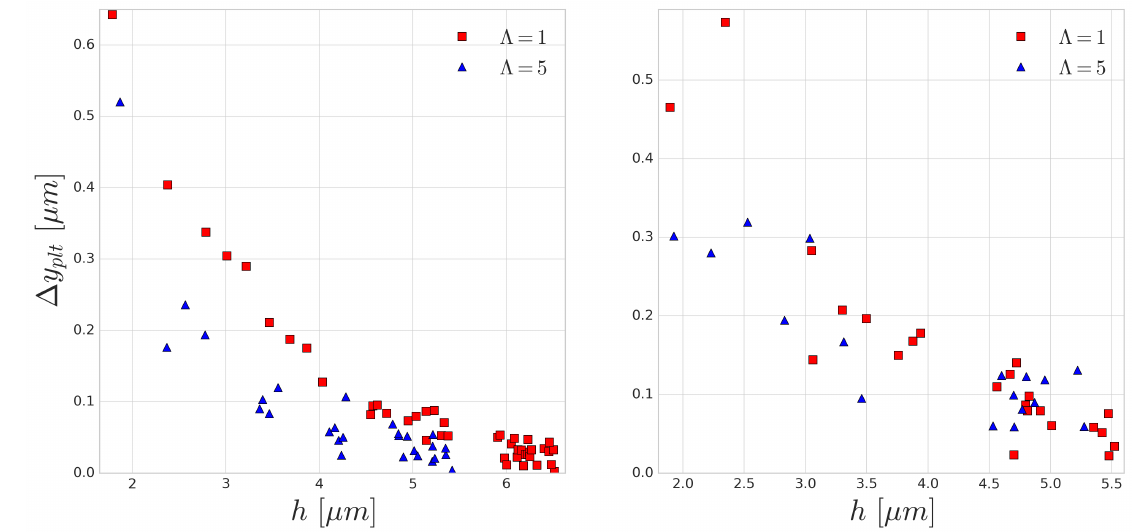
Figure 9. The average platelet displacement after a collision with a RBC depending on the initial collision distance between the cells, h : ( Left ) ˙ γ = 4000 s − 1 ; and ( Right ) ˙ γ = 400 s − 1 .